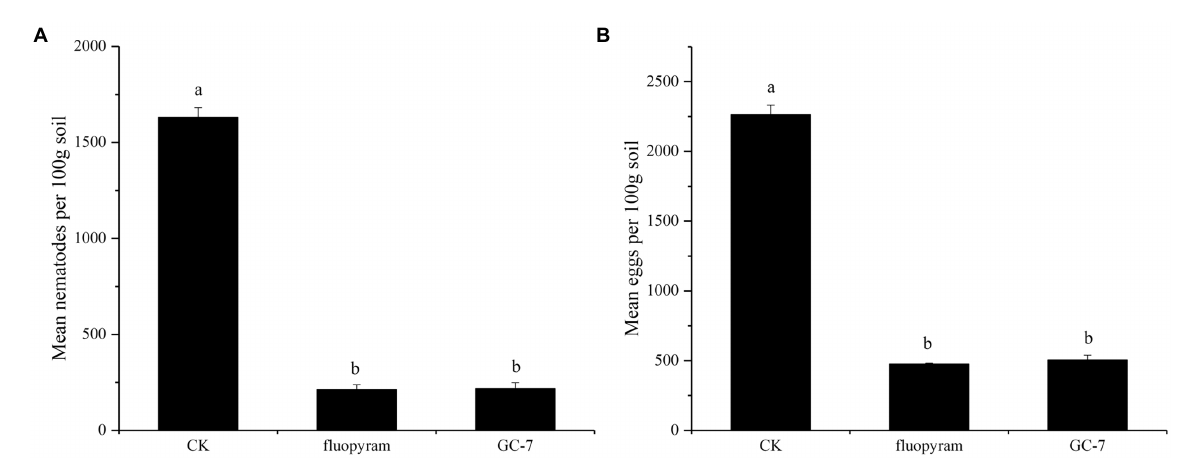
FIGURE 5 Biocontrol of M. graminicola in the field. (A) GC-7 isolate decreased the nematodes in soil. (B) Suppression of M. graminicola eggs by GC-7 in soil under field conditions. At the time of harvest (4 months after planting), the nematodes and eggs in each 100 g soil sample were isolated and counted. Vertical bars represent standard deviation of the mean values. Tukey’s multiple range test was employed to test for significant differences between treatments at p < 0.05. Different lowercase letters indicate significant difference between treatments ( p <